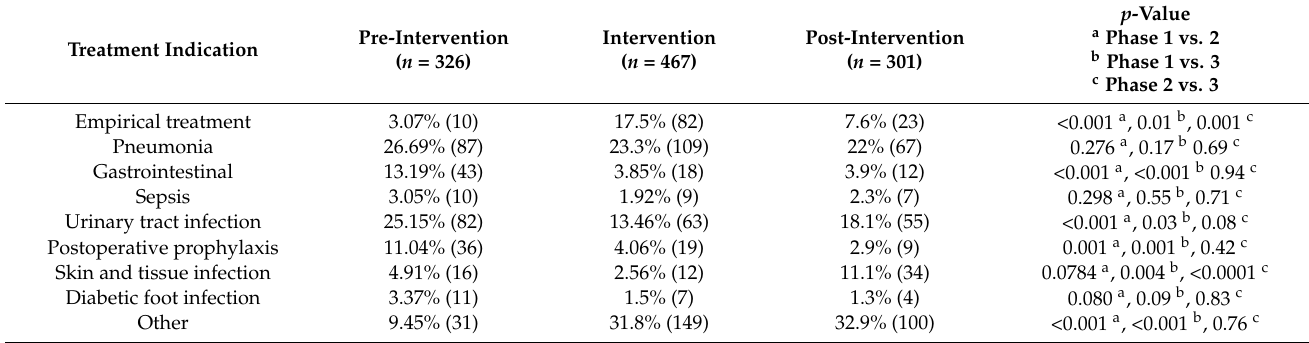
Table 2. Type of infection treated in each phase.